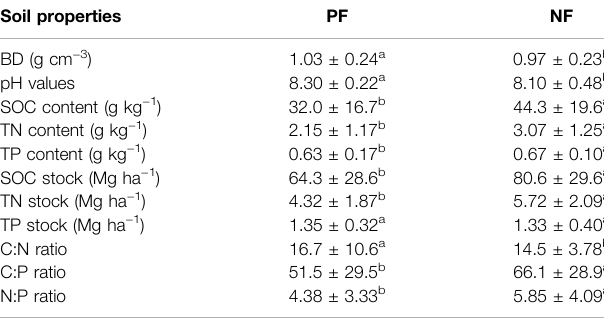
TABLE 2 | The mean physicochemical soil properties of 0 – 100 cm soil depth for PF and NF. Soil properties